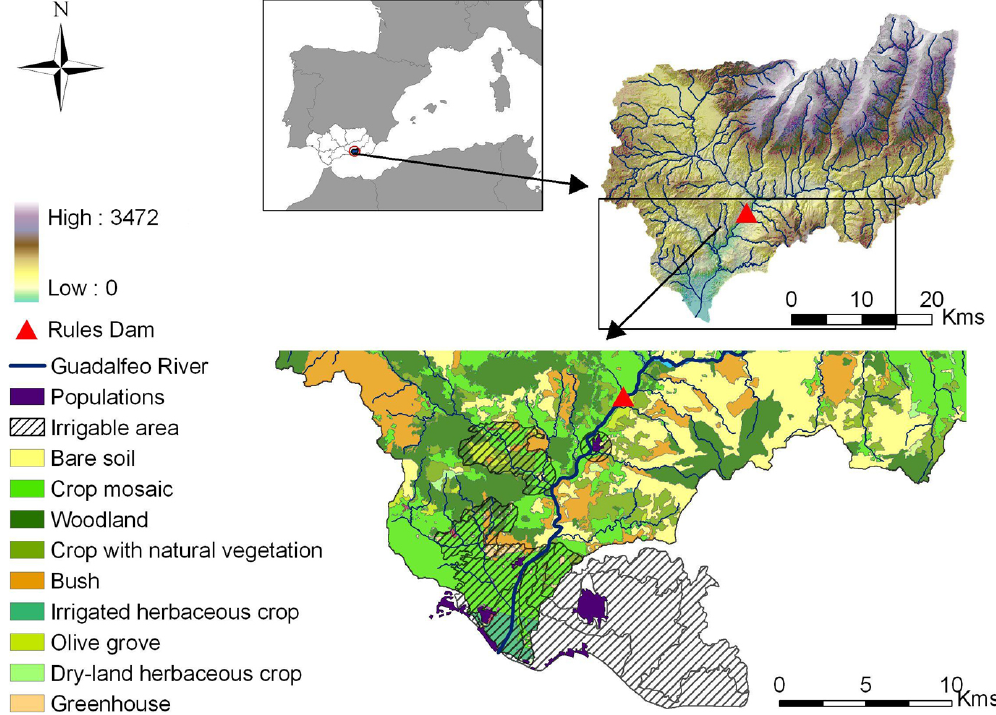
Fig. 1. Situation, Digital Elevation Model and land uses of Guadalfeo river watershed. Urban areas and irrigable areas furnished from Rules reservoir are also